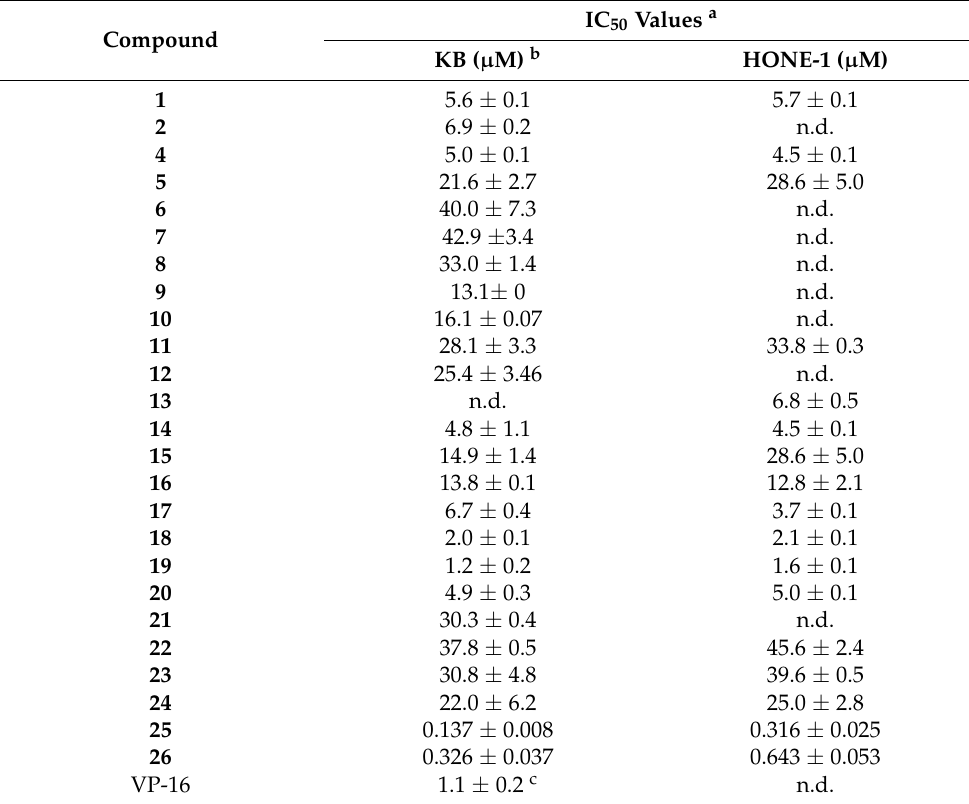
Table 1. Growth inhibition of salvinal derivatives against human cancer